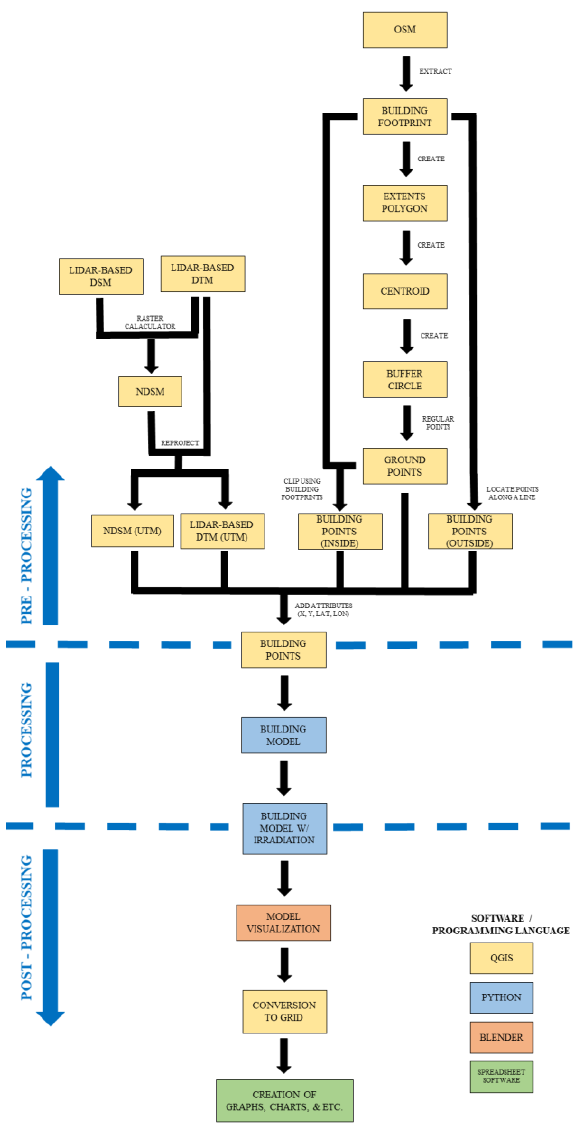
Figure 3. General Methodology of the